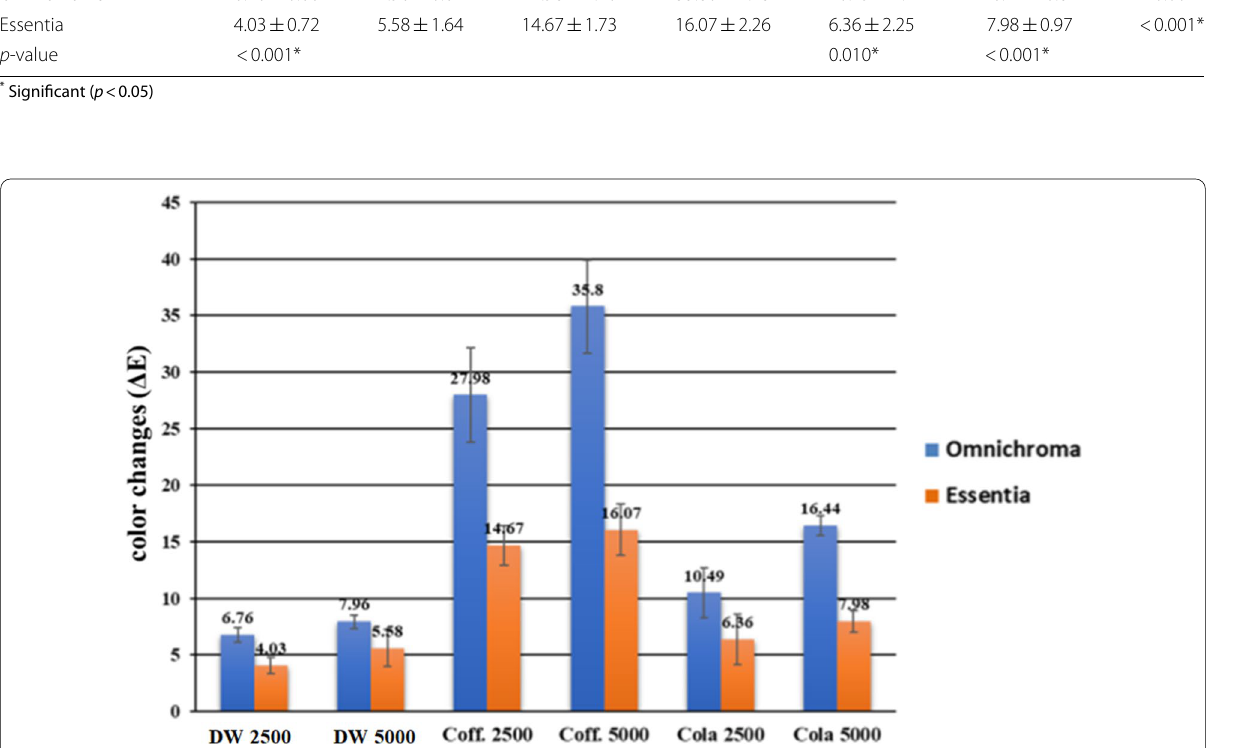
Table 3 The water sorption values in (μg/mm. 3 ) after TC 2500 and 5000 of Omnichroma and Essentia composite